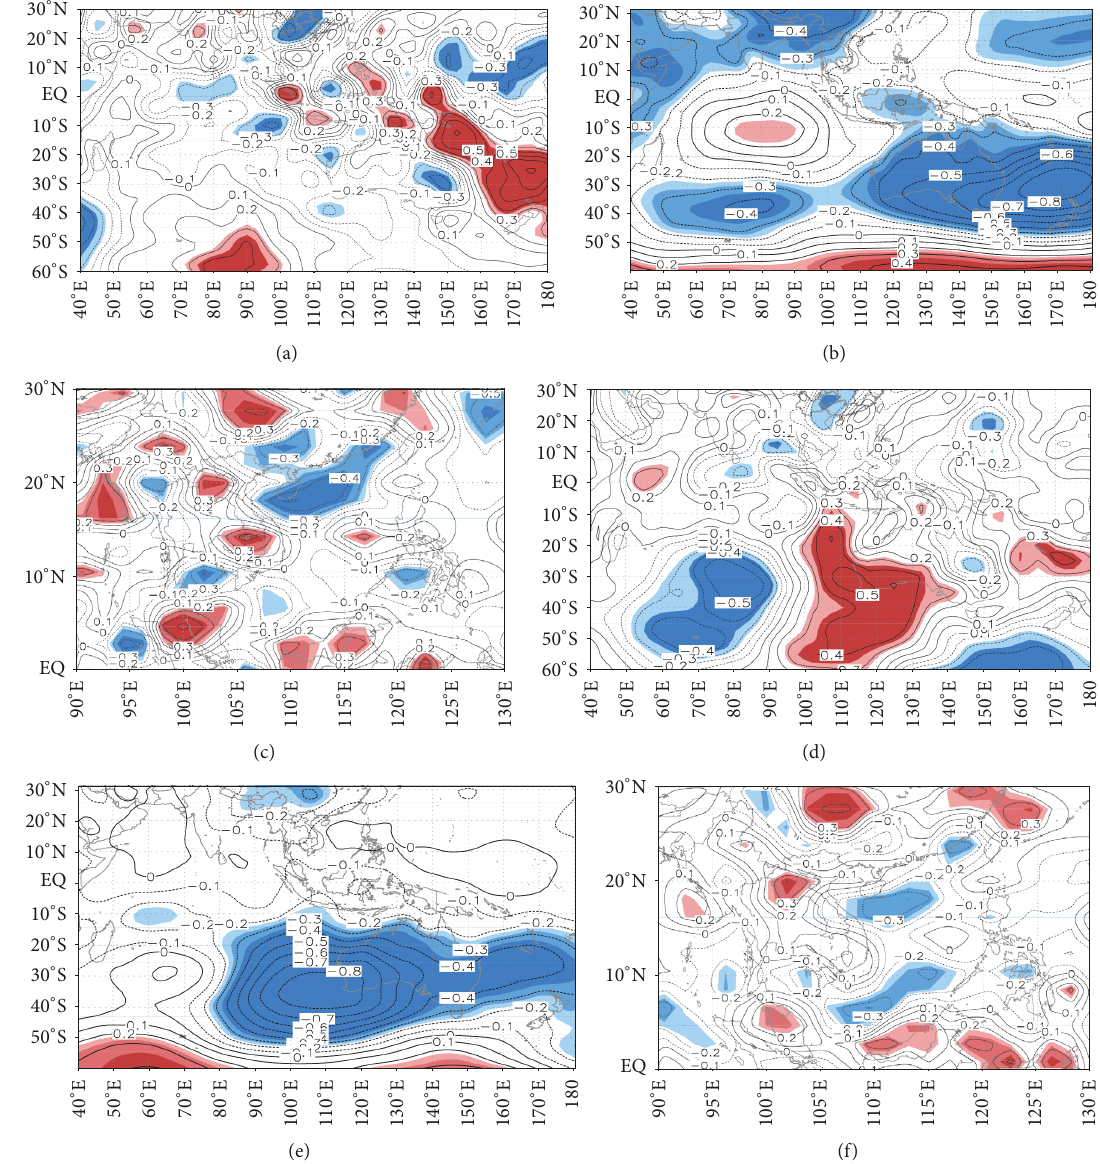
Figure 10: Correlation between the 850 hPa meridional wind, surface wind divergence, and velocity potential with the (a)–(c) IEAH and the (d)–(f) IEMH. Significant values exceeding the 90%, 95%, and 99% confidence levels ( 𝑡 -test) are shaded.